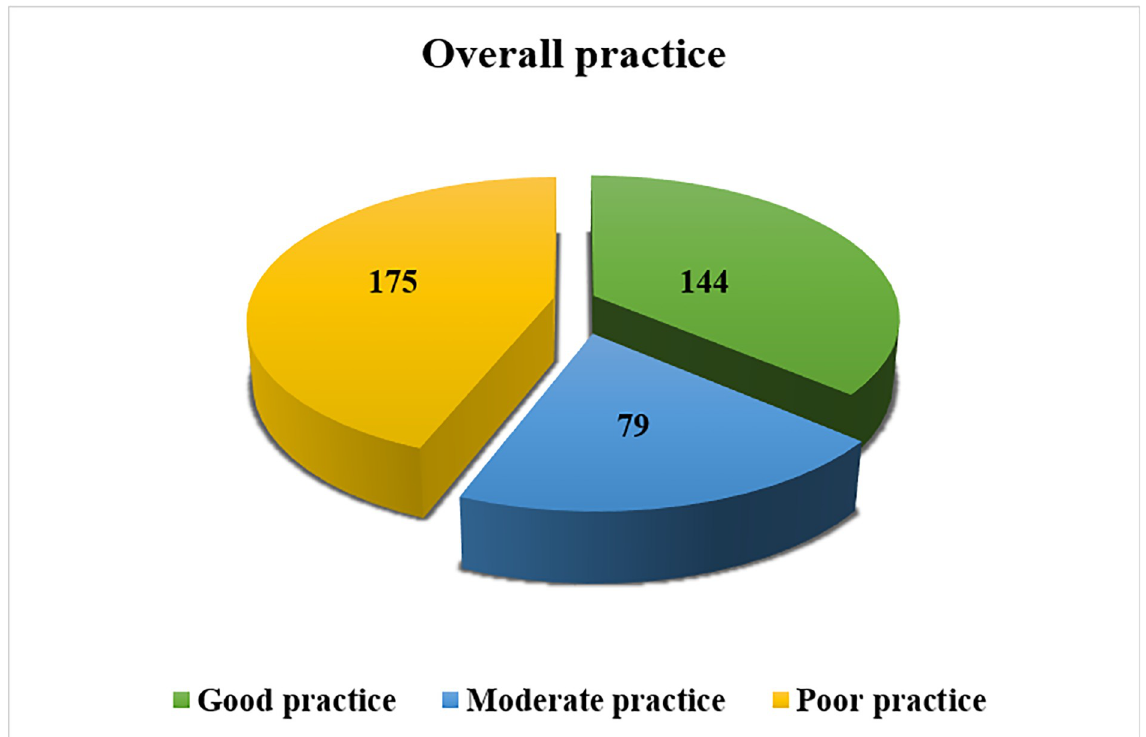
Fig 4. Level of overall preventive practice towards COVID-19 among outpatient service visitors in Debre Markos compressive specialized hospital, Amhara regional state, Ethiopia, 2020.